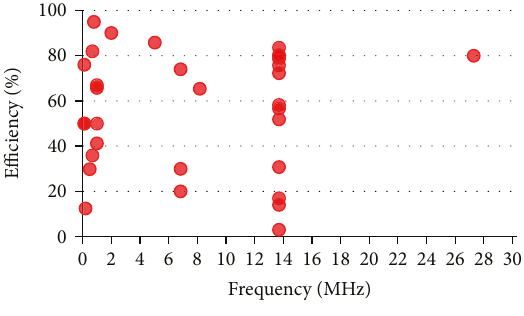
Figure 5: E ffi ciency versus delivered power.